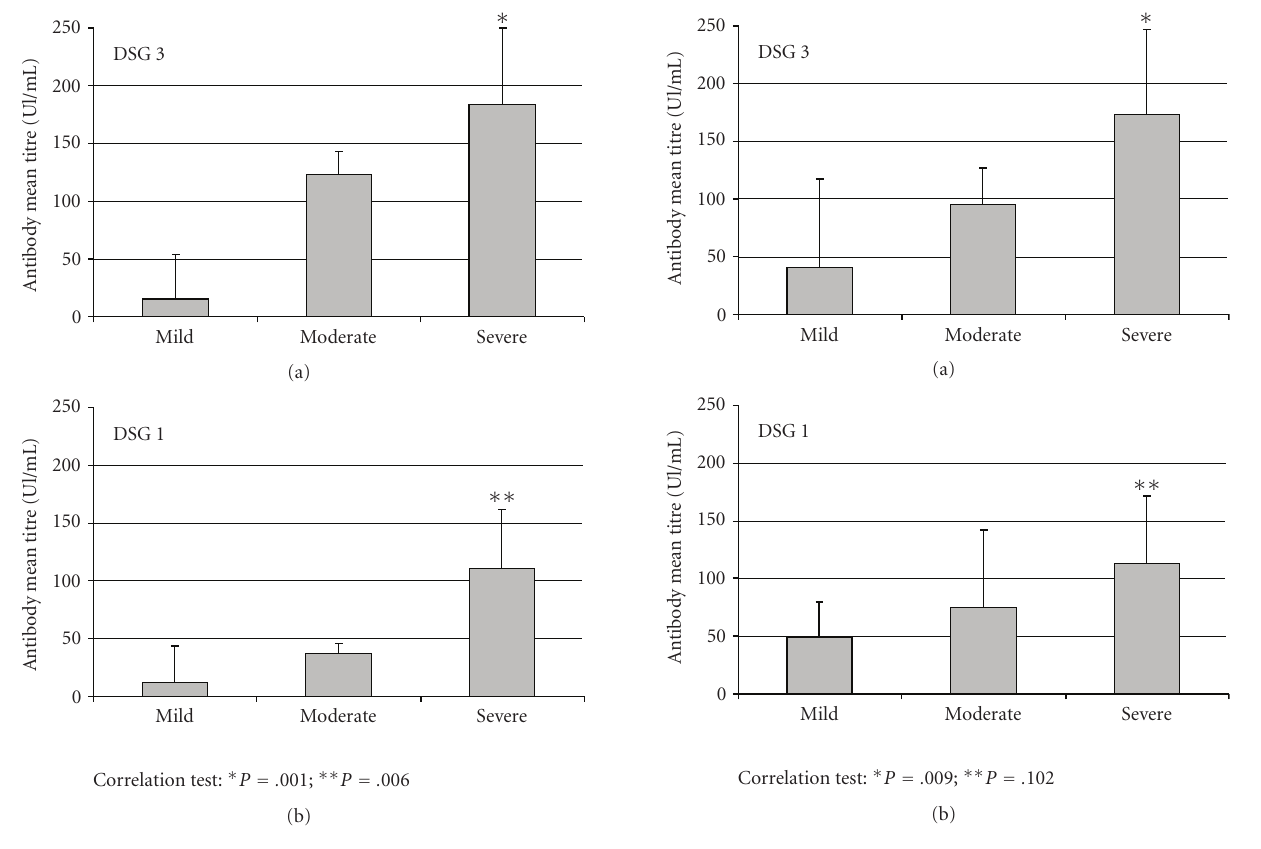
Figure 1: Anti-DSG3 and anti-DSG1 autoantibody mean titres in presence of mucosal involvement.